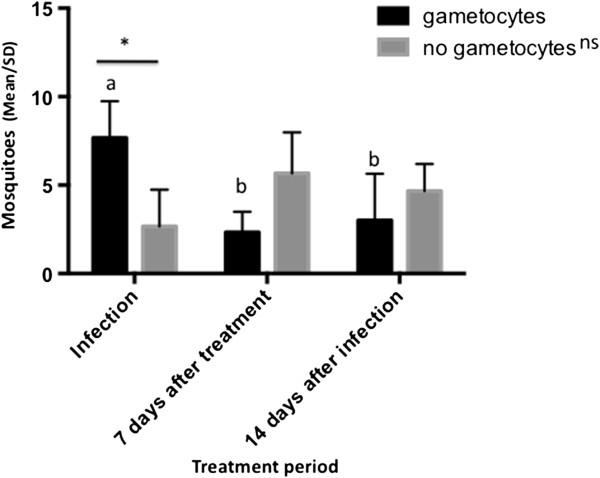
Anopheles darlingi attractiveness to vivax malaria patients during different periods throughout treatment. Two-Way Anova Repeated Measures and Tukey’s test (comparisons). Different letters indicate significant (P < 0.05) differences in mosquito attractiveness to patients bearing gametocytes during the treatment period. NS indicate non-significant (P > 0.05) differences in mosquito attractiveness to patients with no detectable gametocytes during the treatment period. * indicates a significant (P < 0.01) difference in the mosquito attractiveness between patients with detectable gametocytes (gametocytes) (N = 3) and non-detectable gametocytes (no gametocytes) (N = 3) during the infection phase.